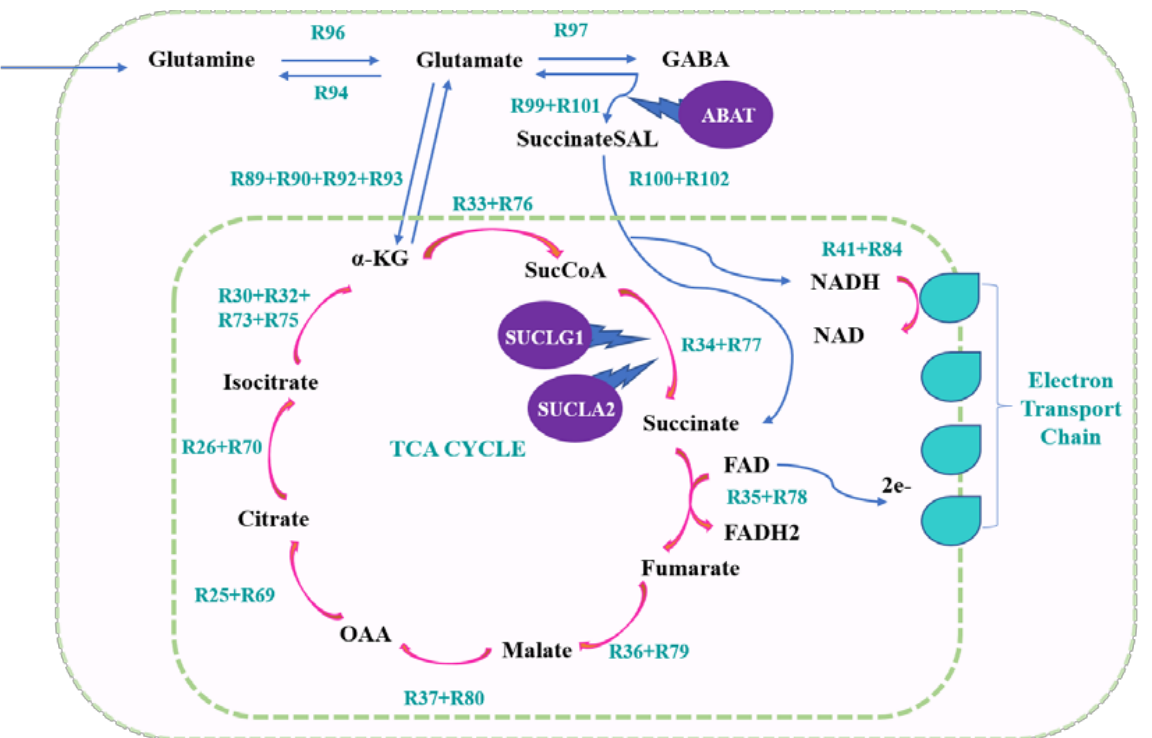
Figure 7. ABAT − SUCLA2 and ABAT − - SUCLG1 synthetic lethal gene pairs determined in double gene deletion analysis in MB model led to succinate and NADH productions related to cancer-promoting effects.